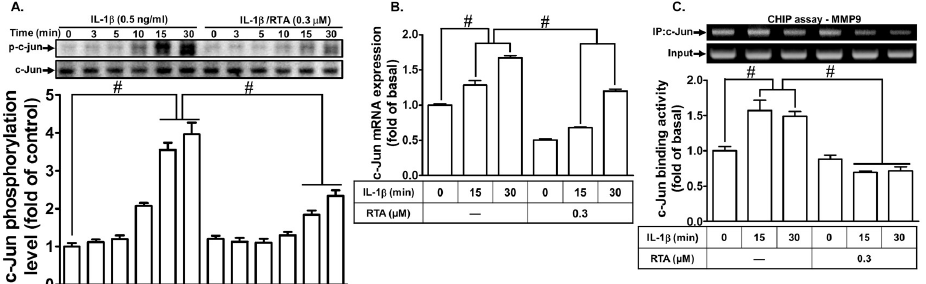
activities. ( A ) Cells were pretreated with RTA 408 (0.3 µM) for 4 h, and then incubated with IL-1β (0.5 ng/mL) for the indicated time intervals (3, 5, 10, 15, and 30 min), the phosphorylation of c-Jun was detected by western blot. ( B ) Cells were pretreated with RTA 408 (0.3 µM) for 4 h, and then incubated